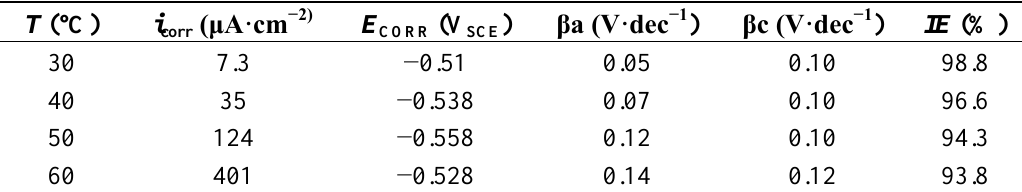
Table 2. Polarization parameters for mild steel in 1.0 M HCl with 0.5 mM of PMBH at different temperatures. The i values for the blank solution at different temperatures were corr taken from our previous study